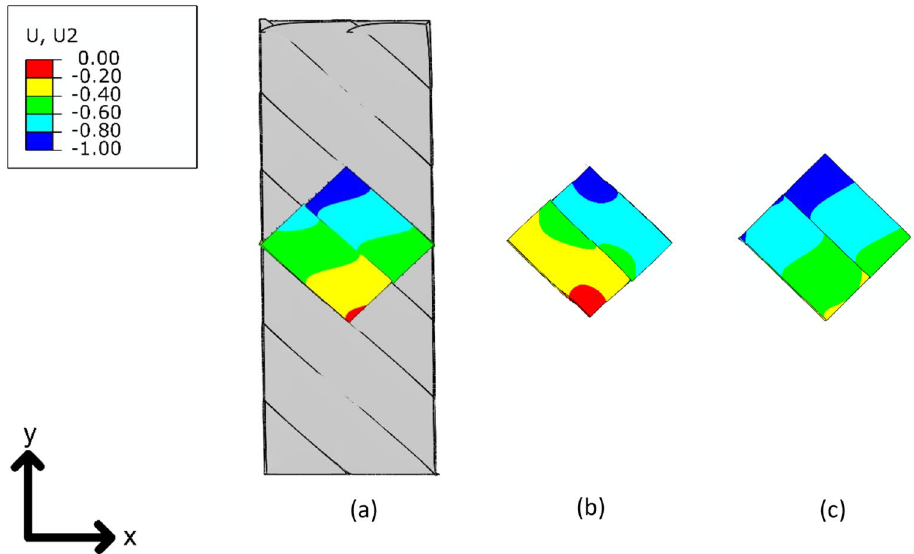
Fig. 6 The relative-to-maxi- mum displacement (neglected direction of displacement) in y -direction for the CLT panel simulated in diaphragm shear simulation a , diagonal compression simulation b , and pure shear simulation c